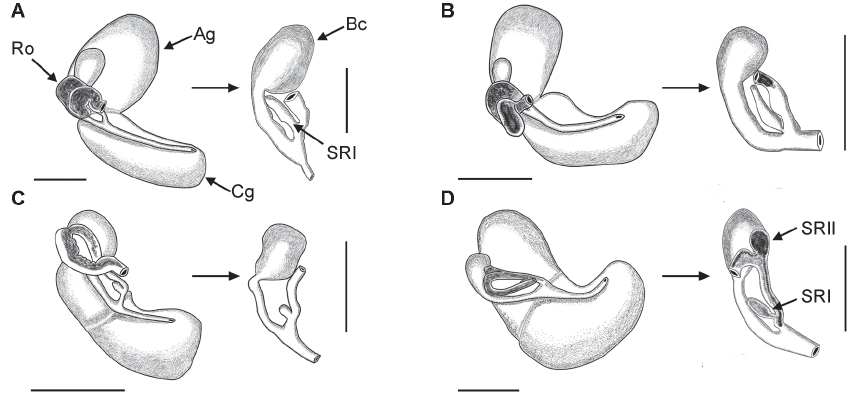
Fig. 10. Distal female genitalia and associated structures of the Ponto-Caspian species. A. Intermaria zagrosensis (Glöer & Pešić, 2009) gen. et comb. nov. B . Intermaria kermanshahensis (Glöer & Pešić, 2009) gen. et comb. nov. C . Persipyrgula saboori (Glöer & Pešić, 2009) gen. et comb. nov. D . Shadinia terpoghassiani (Shadin, 1952). Anatomical abbreviations given in the Material and method section. Scale bars: 500